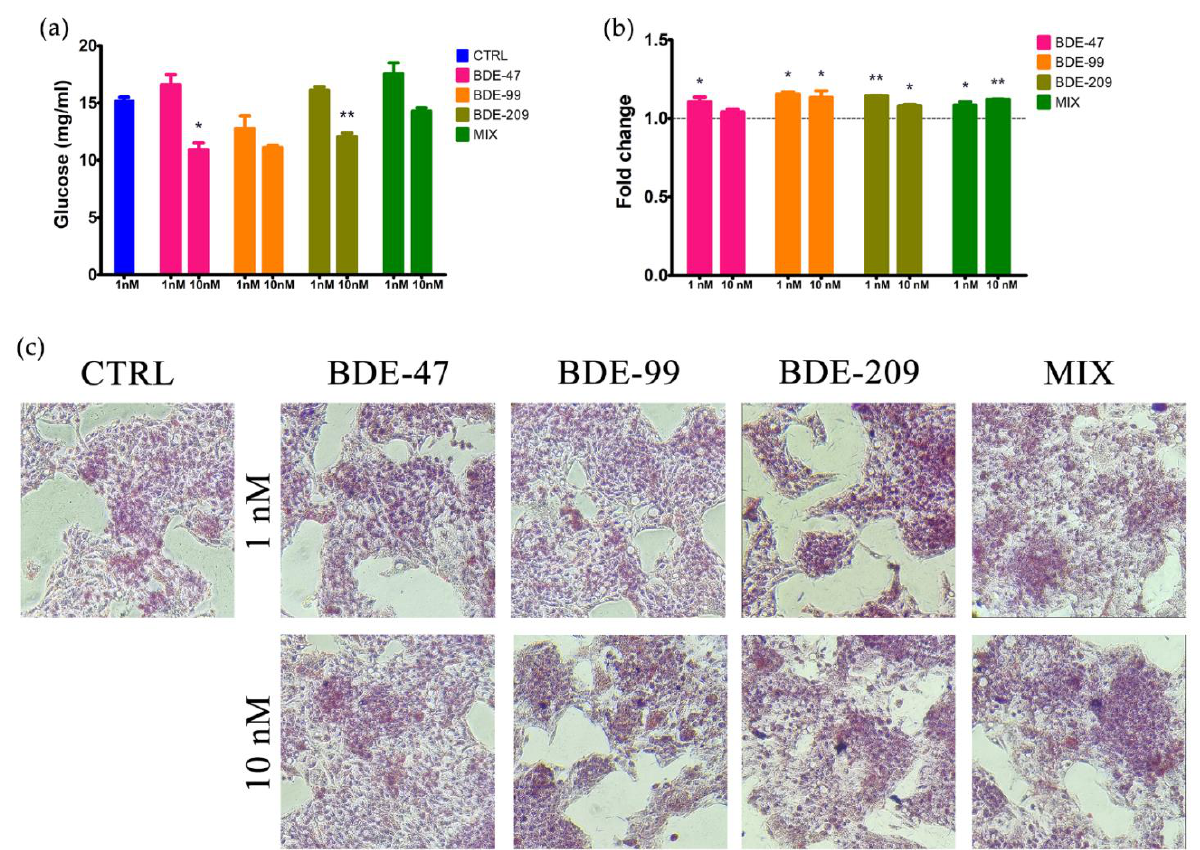
Figure 7. ( a ) Glucose levels measured in conditioned medium of HepG2 cells treated for 72 h with BDE-47, -99, -209 or their ternary mixture (MIX) at 1 and 10 nM. ( b ) Intracellular lipid accumulation detected by fluorescence reading of oil red staining in HepG2 treated as described in ( a ). ( c ) Representative images of HepG2 oil red staining in all the experimental conditions (40× captured images on a Nikon Eclipse Ts2, Nikon Europe B.V. Amstelveen, The Netherlands). Asterisks indicate the level of significance: * p < 0.05; ** p < 0.01.